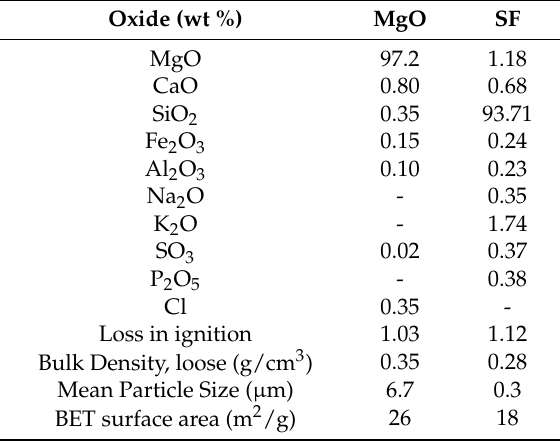
Table 1. Characteristics of the raw materials (manufacturer